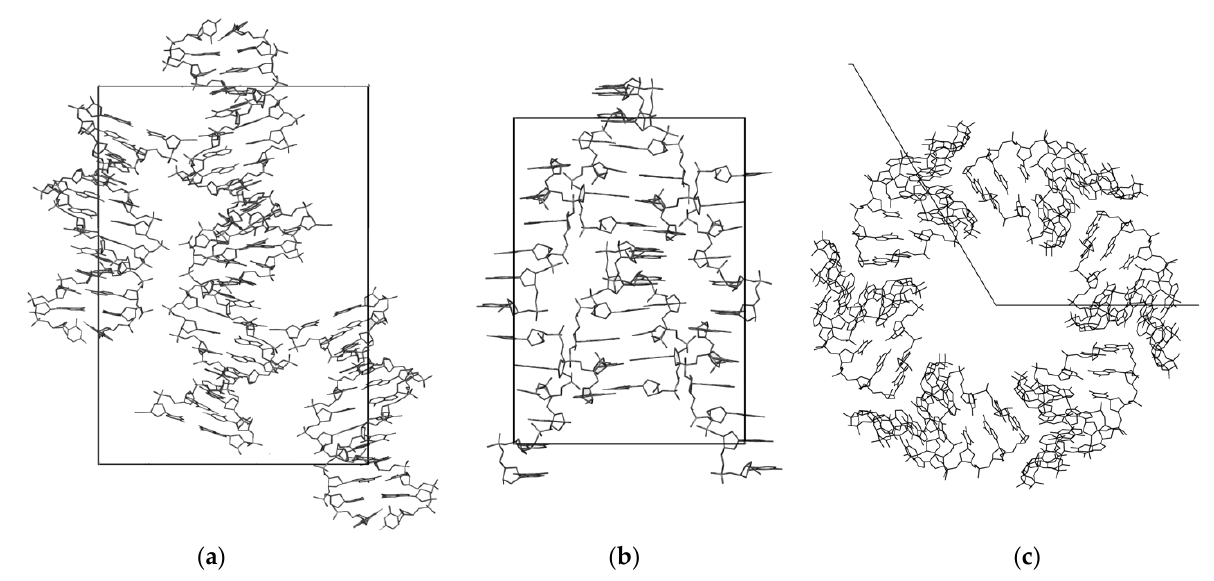
Figure 3. The three DNA crystal packings. ( a ) The B-DNA dodecamer and ( b ) the Z-DNA hexamer both with their c -axis vertically oriented. ( c ) The A-DNA octamer is viewed along the c -axis showing the associations of the twisted duplexes that form a superhelix delimiting a central void channel. Table 4. Dependency of the unit-cell parameters vs. the applied pressure. Pressures are in GPa, unit-cell dimensions are in Å, volume in Å 3 , and compressibility coefficients χ in GPa − 1 . The grey rows in the Table correspond to values from full data collections, the others from frames collected only in a short rotation range. Estimated standard deviations on cell parameters are in the range of 0.005–0.01 Å (1 to 3 Å 3 on volumes). In each case, the last column reports the specific compressibility coefficient χ